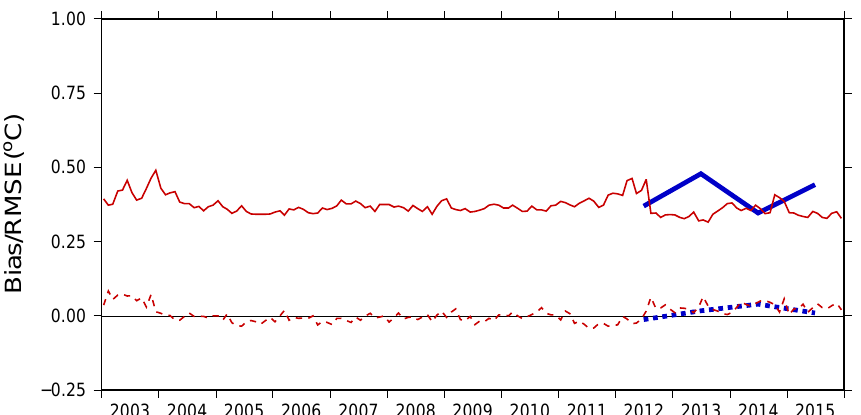
Figure 8. Global validation statistics of the satellite foundation SST against in situ foundation SST by drifting buoy (red, semi-annually). and Argo floats (blue, semi-annually). Calculated RMSE and bias are shown by solid and dashed lines,